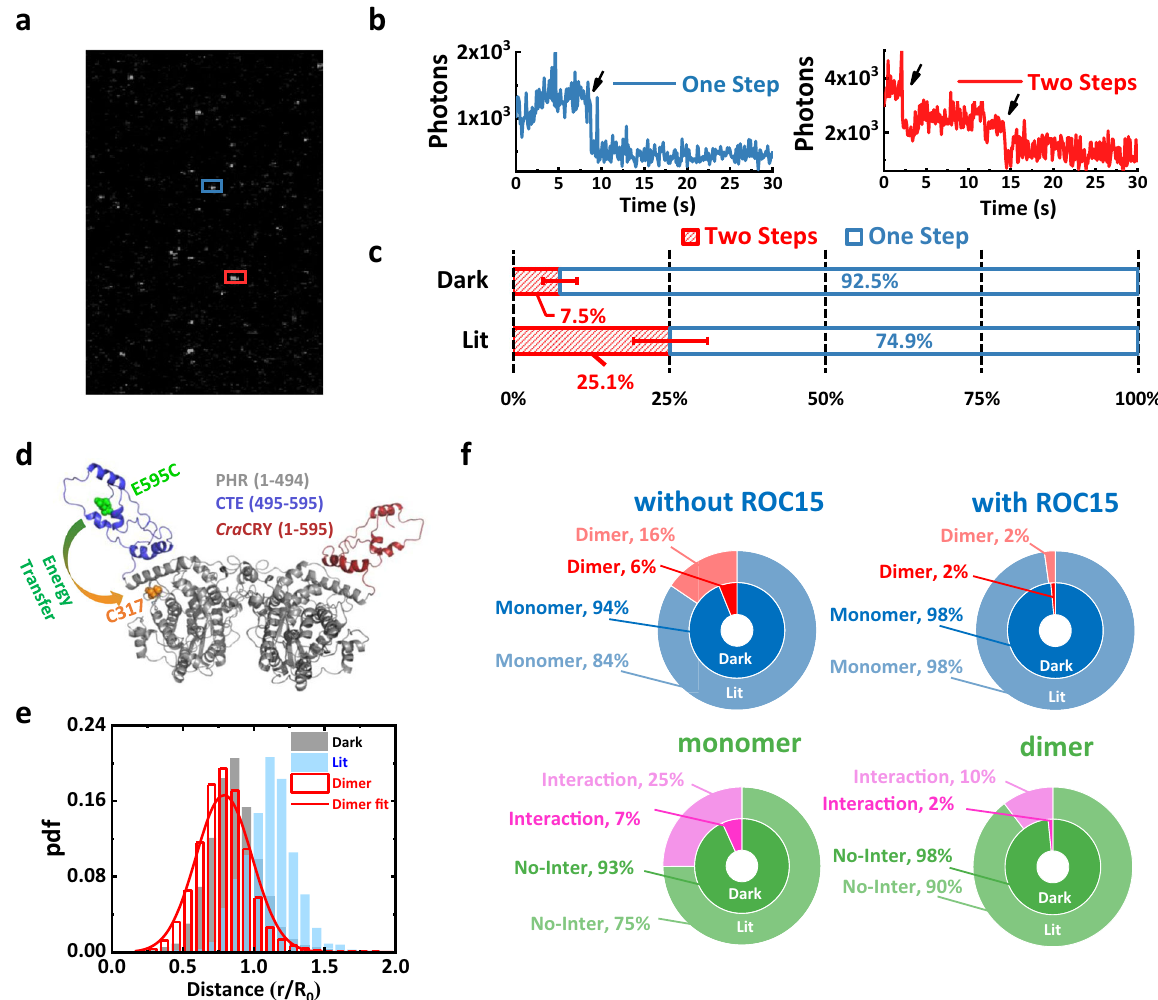
Fig. 4 Blue-light-induced dimerization and Cra CRY – ROC15 interaction are mutually exclusive. a Fluorescence TirfM image of Cra CRY::mCitrine proteins upon blue-light illumination. Every bright spot corresponds to an isolated protein complex. The point in the blue box denotes a protein complex, with one- step bleaching (blue trajectory in panel b ) detected in this protein complex, whereas the protein complex in the red box exhibited two-step bleaching (red trajectory in panel b ). b Single-molecule fl uorescence trajectories showing the mCitrine fl uorescence intensity with one (blue) or two (red) bleaching steps. c Monomer (blue) and dimer (red) fractions under dark and lit conditions. The error bars are the statistical standard deviation, see Supplementary Table S4 for exact values. d Schematic representation of the smFRET assays for Cra CRY dimer. The CTE, PHR, and labeling sites for smFRET assays are shown in the fi gure; the red colored cartoon shows the other Cra CRY molecule (no FRET labeling) in the dimer model. e Distribution of the distance between C317 and E595C of the Cra CRY in dimeric state, shown as a red histogram. The gray and blue histograms are the distance distributions of monomers in dark and lit states, respectively. The red solid line shows the fi tting results to the distances in dimeric Cra CRY. f Mutually exclusive relationship between Cra CRY dimerization and Cra CRY – ROC15 intermolecular interaction. The blue and red donut charts show the dimer fractions (red) with or without ROC15 under the dark (dark blue and dark red) and lit (light blue and light red) conditions. The green and magenta donut charts show the Cra CRY – ROC15 interaction fractions with or without Cra CRY dimerization under the dark (dark green and dark magenta) and lit (light green and light magenta) conditions. The experiments demonstrated the mutually exclusive relationship between Cra CRY dimerization and Cra CRY – ROC15 intermolecular